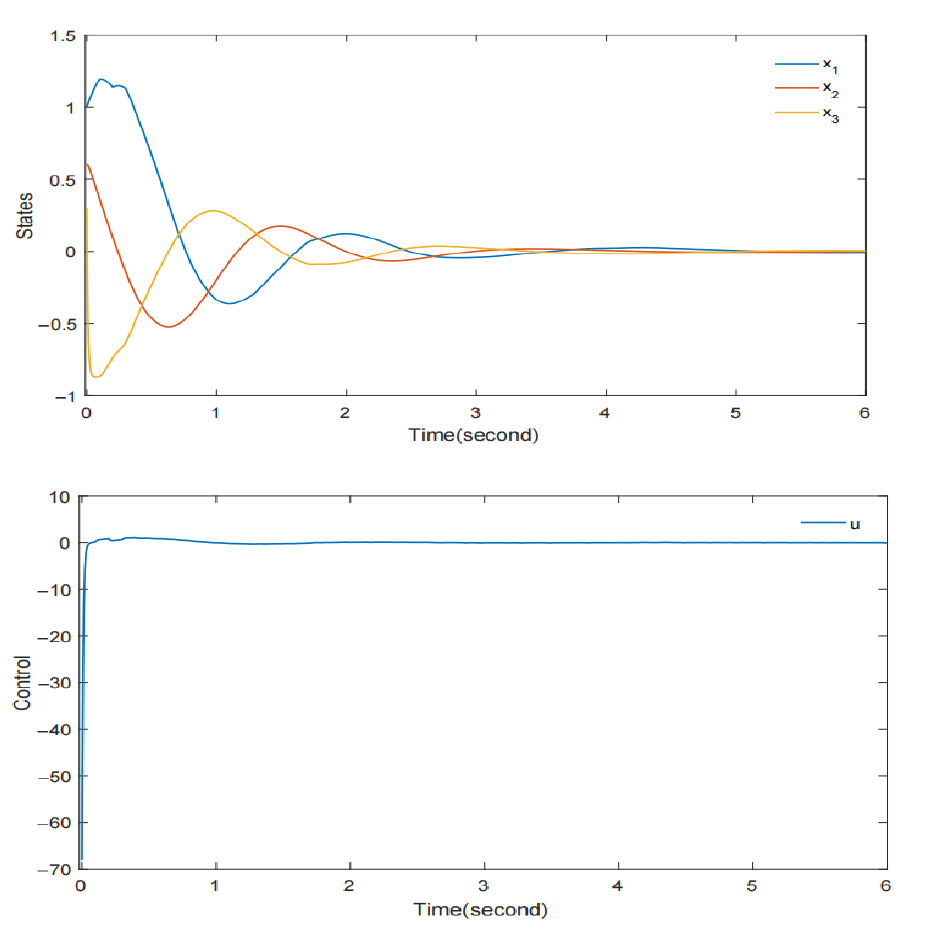
Figure 1. The responses of a closed-loop